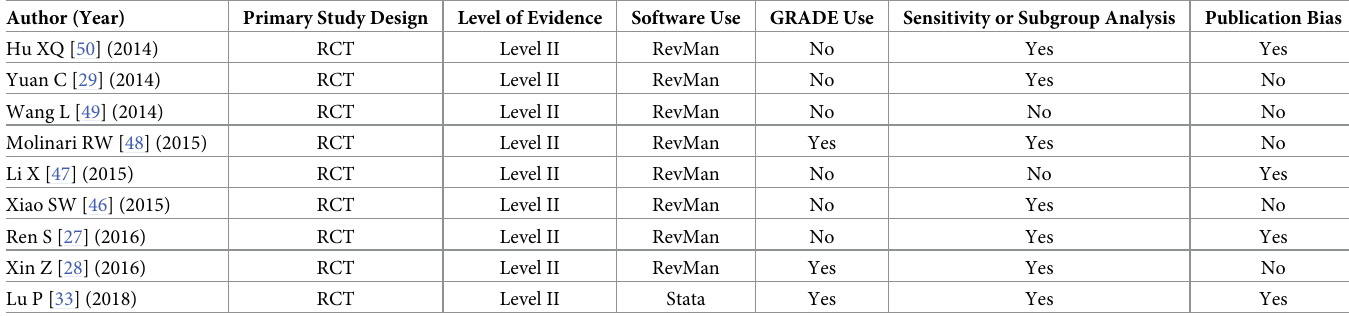
Table 4. Methodological information of each study.